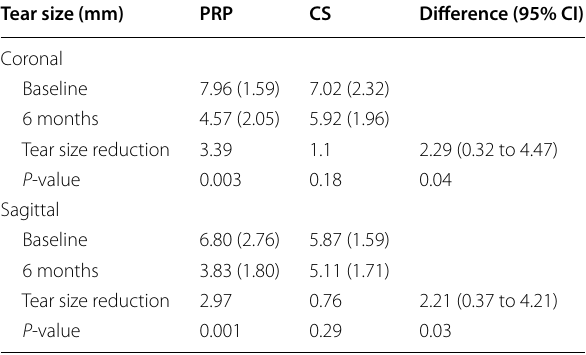
The baseline and 6-month tear size values are presented as mean (standard deviation) PRP platelet-rich plasma, CS corticosteroid, CI confidence interval